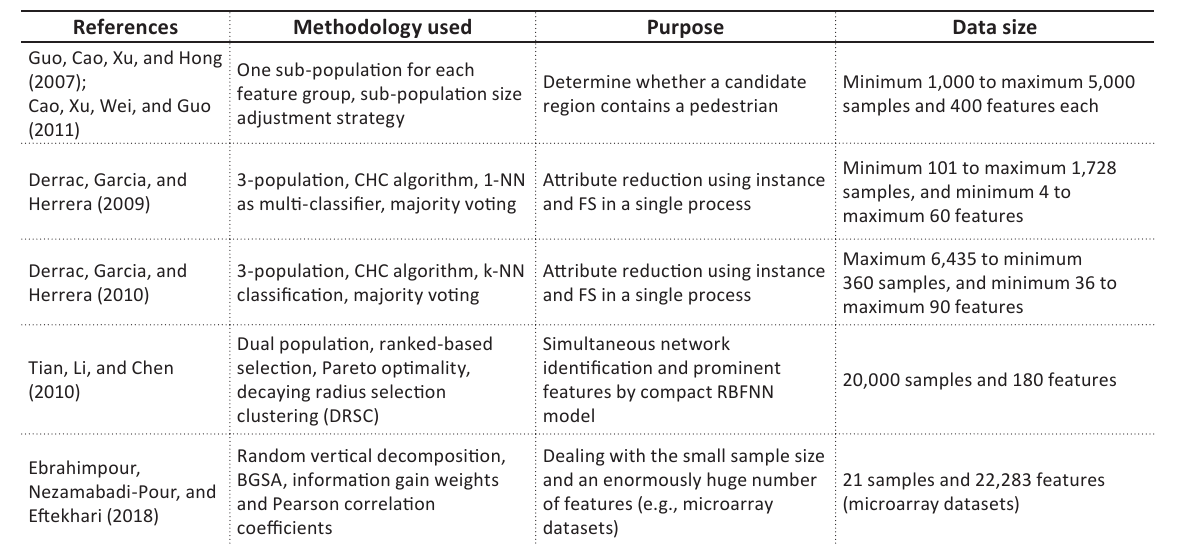
Source: Developed by the